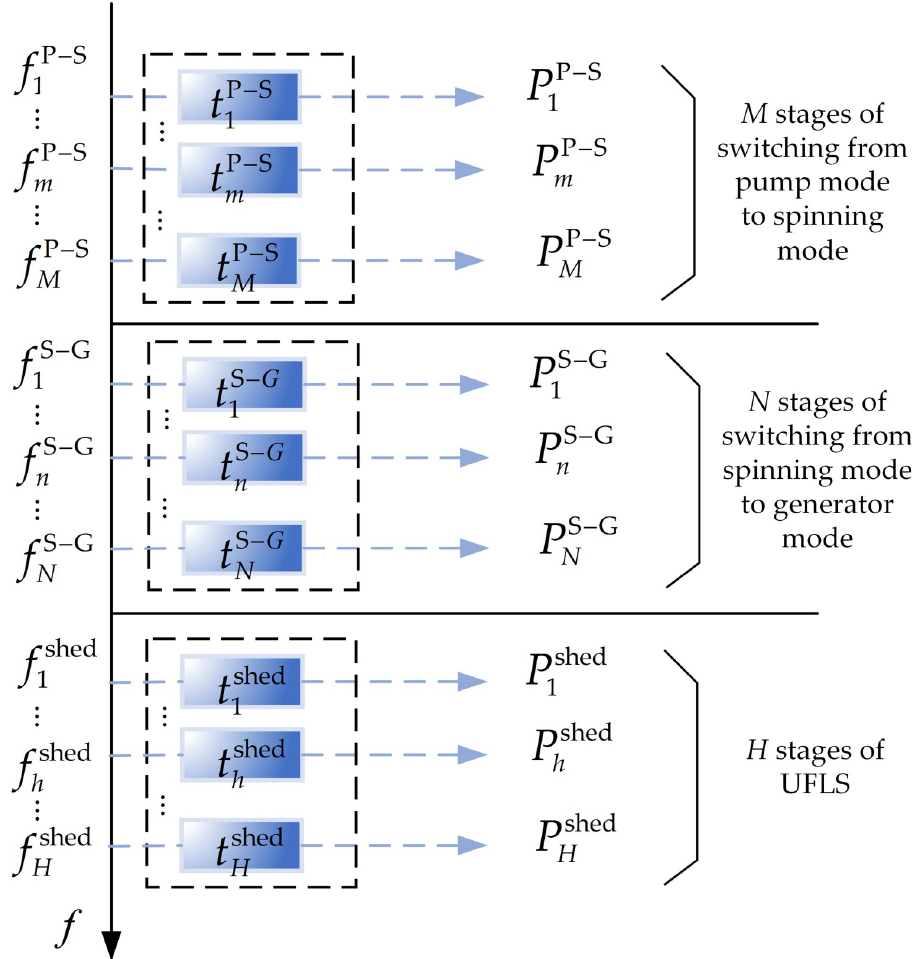
Fig 4. The coordination control